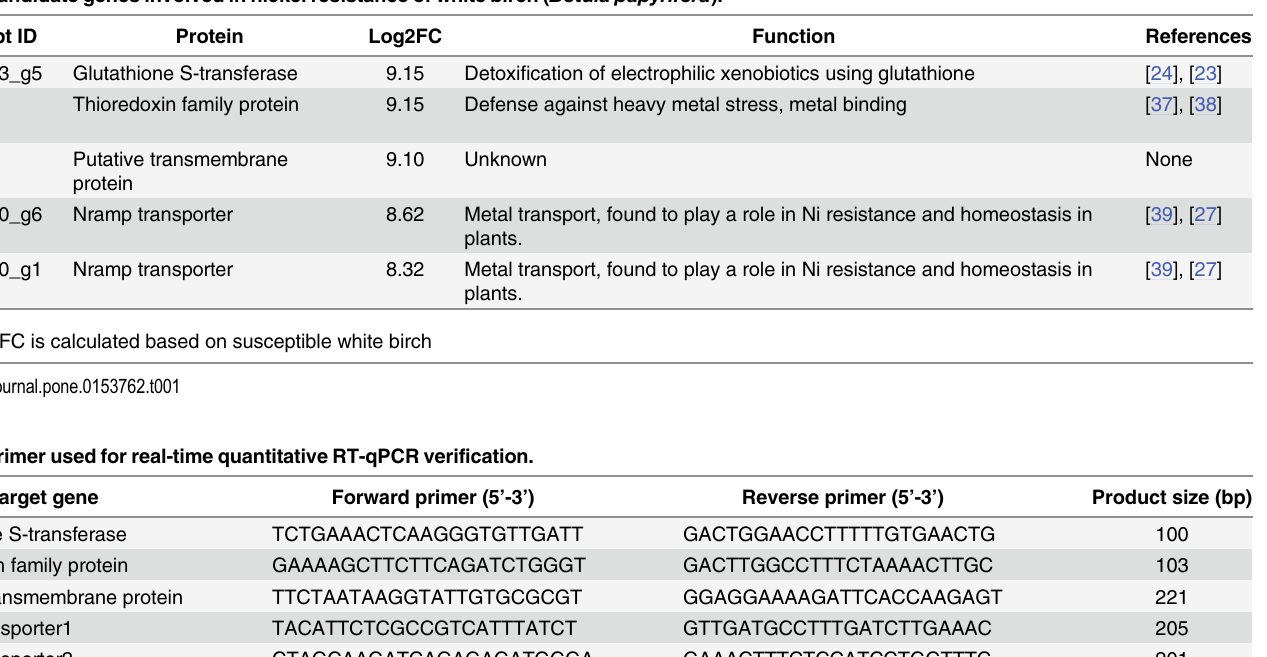
S1 Fig. Top 50 differentially expressed genes between nickel – treated Betula papyrifera resistant genotypes and control (nickel-untreated) based on logFC. The red colour repre- sents an upregulation and blue downregulation.